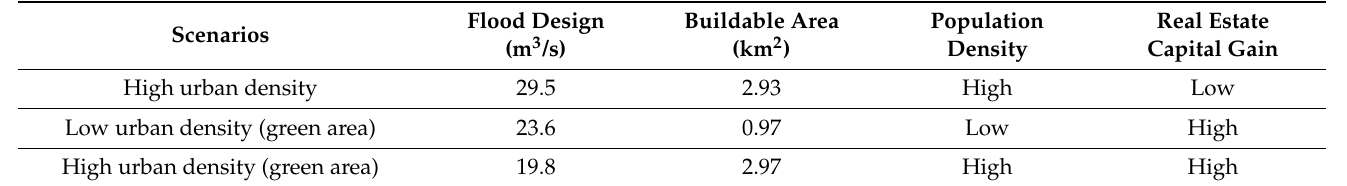
Table 3. Comparison of design flood estimation, buildable area, population density, and real estate capital gain between the three scenarios proposed for the studied micro-watershed. Flood design estimation is presented after a 25-year return